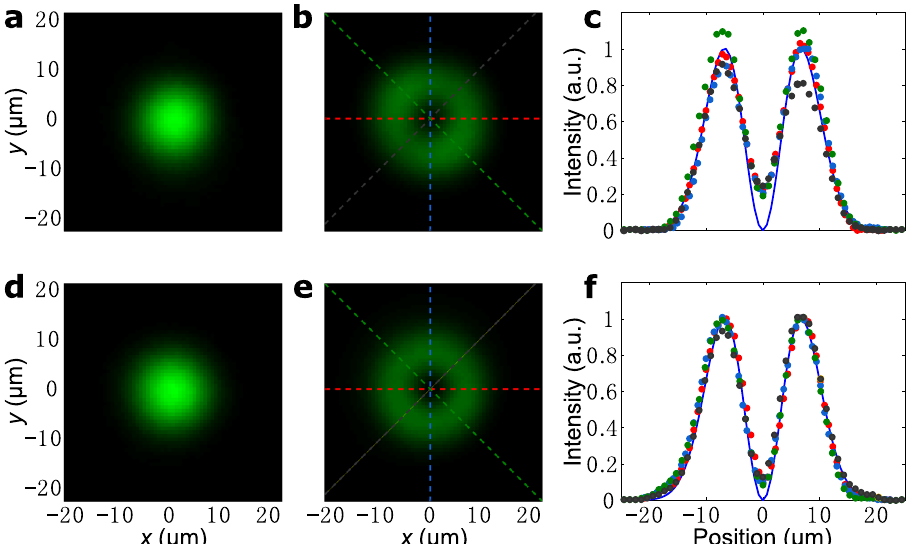
Fig. 3 Spatial differentiation on an input Gaussian beam and generation of orbital angular momentum. a Incident Gaussian beam using the total internal re fl ection setup shown in Fig. 2a. b Measured output beam, corresponding to the transfer function in Fig. 2b. c Pro fi les of the output beam along different directions. The dotted lines correspond to the data on the same-color dashed lines in ( b ), and the solid line is the ideal result, as calculated by using Eq. (6) to operate on an input Gaussian beam. d – f Same as ( a - c ), except for that we operate at the Brewster angle in a setup as shown in Fig. 2h. In e the used transfer function is the one shown in Fig. counterclockwise (Fig. 2g) rotating directions of the spiral fringes indicate the opposite topological charges of l = − 1 and l = + 1, respectively.